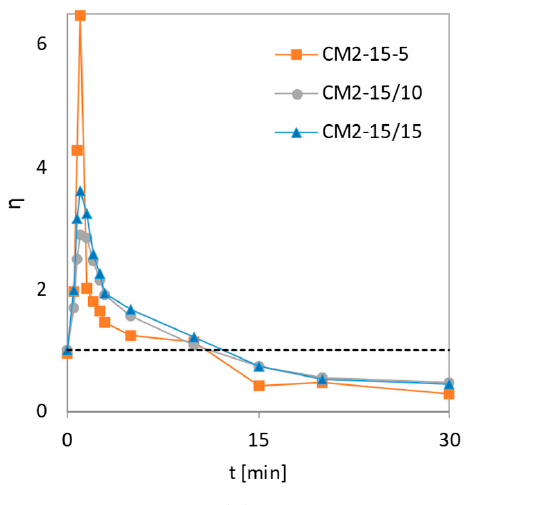
Figure 8. SEM image ( a ) and EDS map ( b ) of the co-milled mixture of MLX with 10 mm balls for 10 min; 15 wt.% SLS (CM10-15/10). Sodium-rich regions are represented as green, and sodium-defi- cient regions are represented by red.